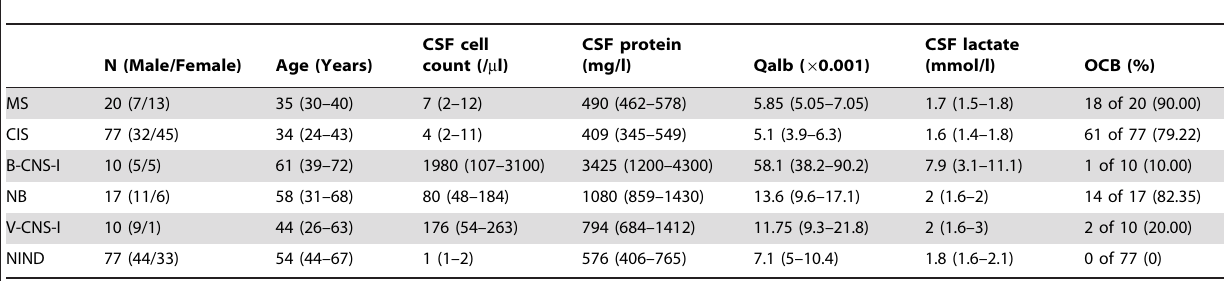
Table 1. Demographic data and basic cerebrospinal fluid